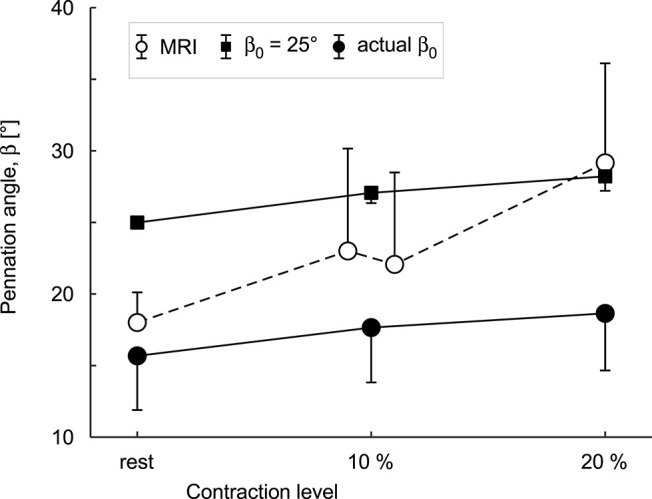
Mean pennation angles (β¯) in a block of 30 × 10 × 10 mm in the middle of the medial gastrocnemius muscle belly. Data are shown for muscles at rest and during 10% and 20% plantarflexion torques as predicted by the simulations (black squares for β0=25∙ and black circles for actual β0) and as measured from DTI scans (white circles). Circles and error bars are the means and standard deviations of the data/models from four participants. Results are shown for simulations with the DTI-derived initial fibre orientations (actual β0) and for simulations in which β0 initial was set to 25° so that the simulated fibre orientations at 20% activation were a closer match to the orientations measured with DTI at 20% plantarflexion torque.